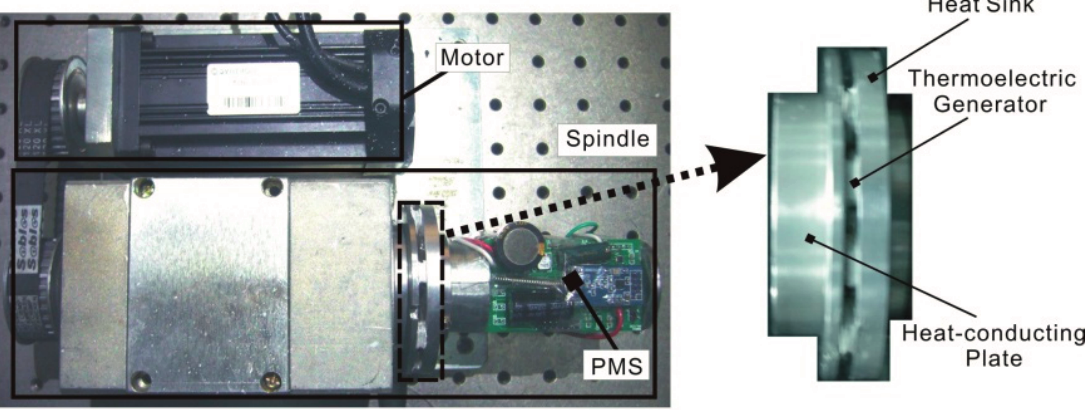
Figure 7. Experimental platform.